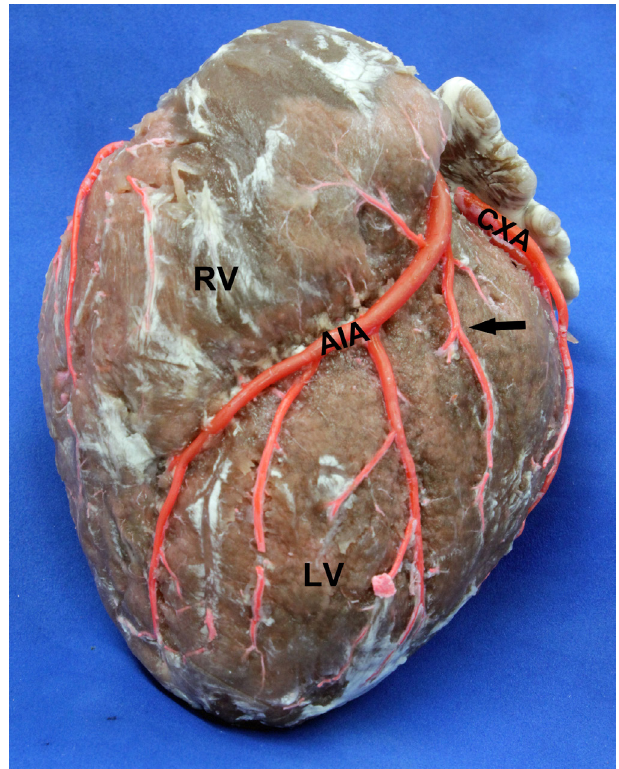
Fig. 3 - Anterior view of the heart. LV: Left Ventricle. RV: Right Ventricle. AIA: Anterior Interventricular Artery. CXA: Circumflex Artery. Arrow: Antero Superior Branch, finishing in the middle third of heart obtuse edge